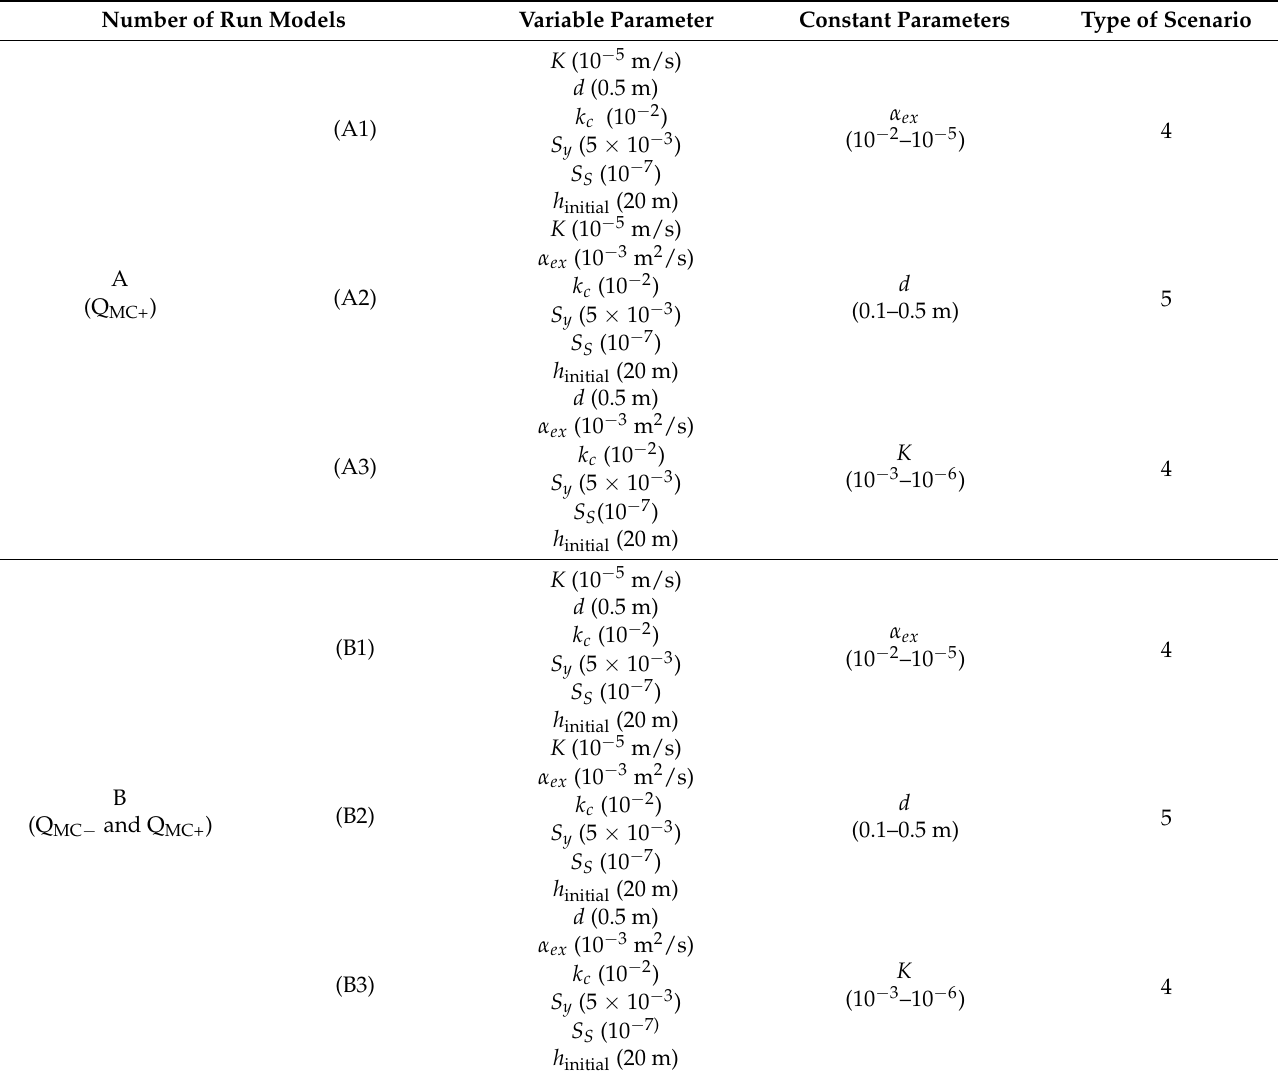
Table 1. The detailed specifications of the scenarios ( K is the hydraulic conductivity of the matrix, d is conduit diameter, k c is roughness, S y is specific yield, S S is specific storage, and h initial is the initial hydraulic head in the